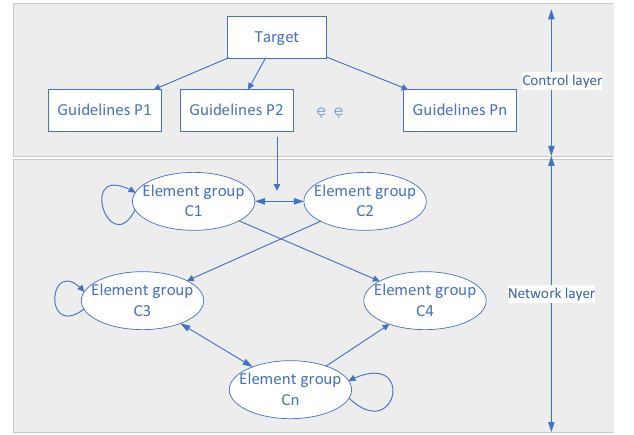
Figure 2. ANP typical